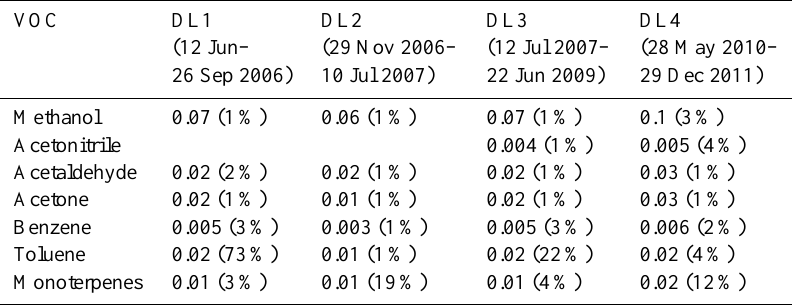
Table 1. Detection limits (ppb v ) for 1h averages of the measured VOCs during the measurement periods. Percentages of values below detection limit are presented in